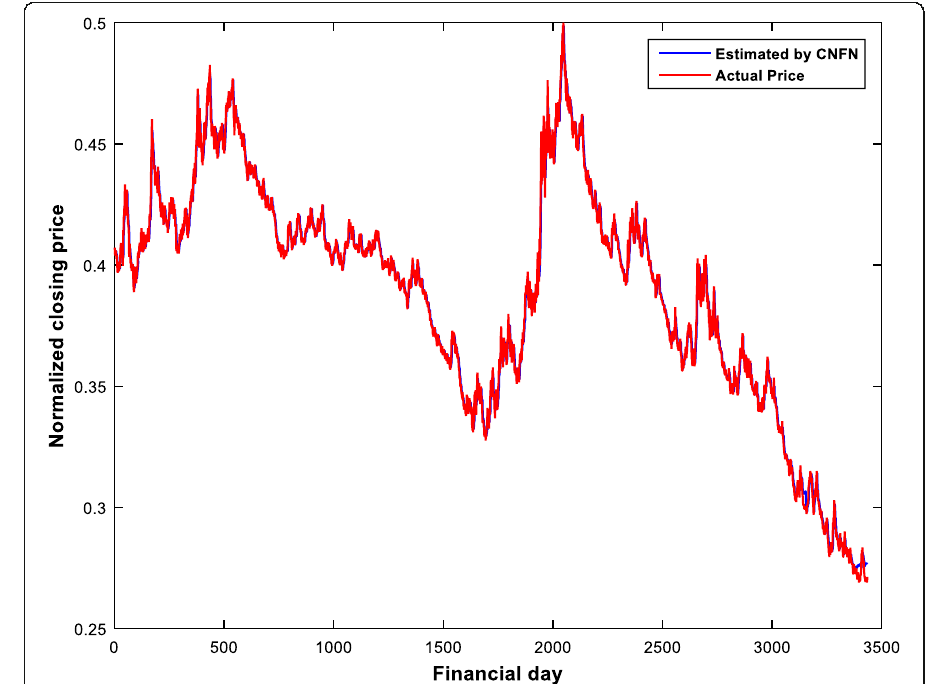
Fig. 14 Estimated v/s actual closing prices by CNFN forecasting model for DJIA stock market data